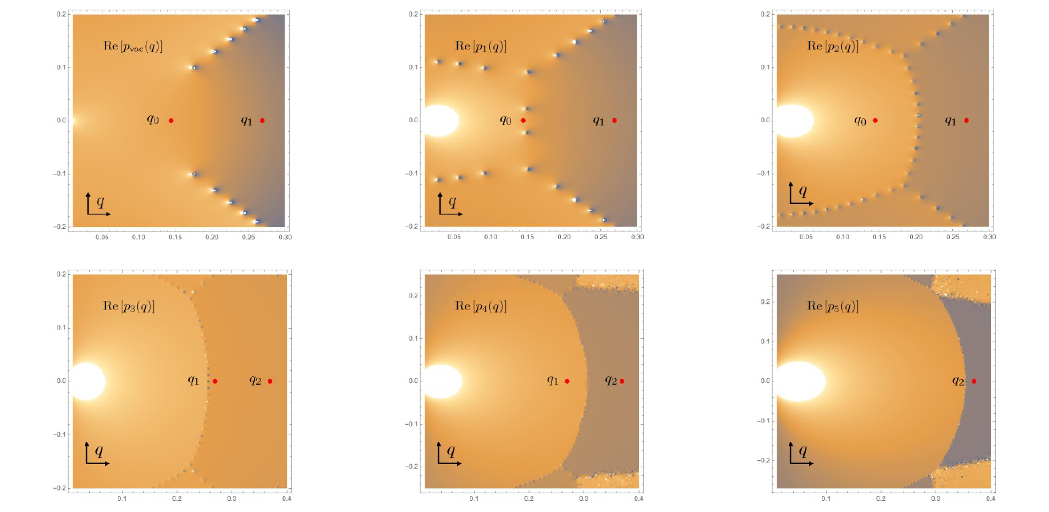
Figure 19 . Real parts of the (cid:12)nite c accessory parameters p the complex q -plane. Parameters used: c = 60 ; (cid:15) L = 1 = 10 ; (cid:15) H = 2. Red dots q i are locations for the forbidden singularities in the q